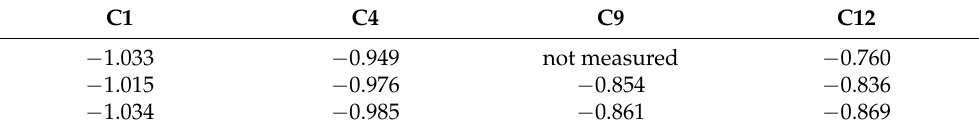
Table 2. Potential values (V vs. Ag/AgCl-seawater) measured at day 18 for each of the 3 experiments.